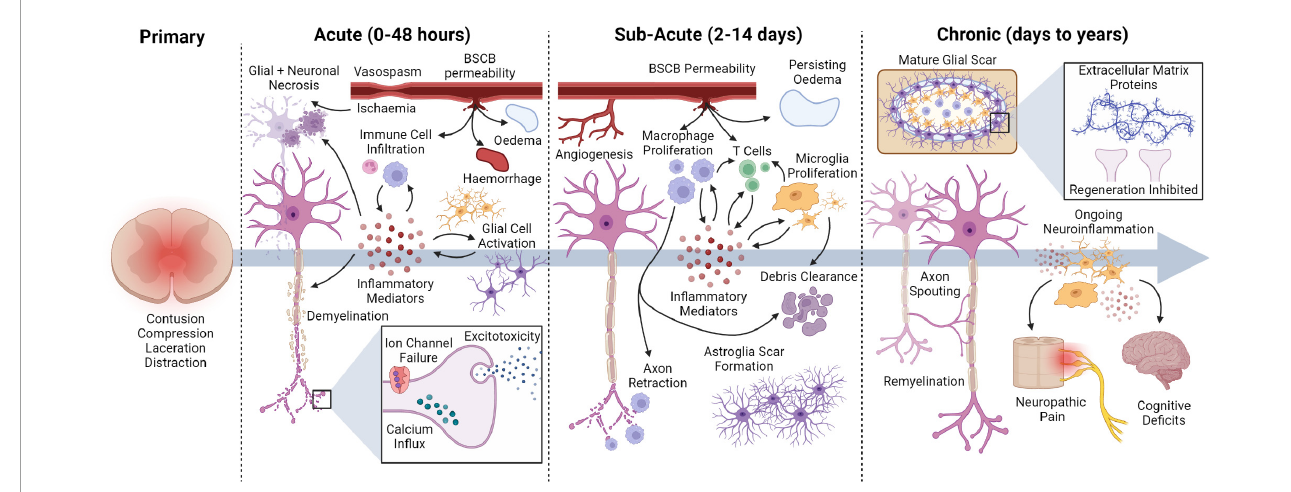
FIGURE1 Overview of secondary injury events following traumatic SCI, highlighting key pathophysiological events that occur throughout the acute, subacute, and chronic stages of